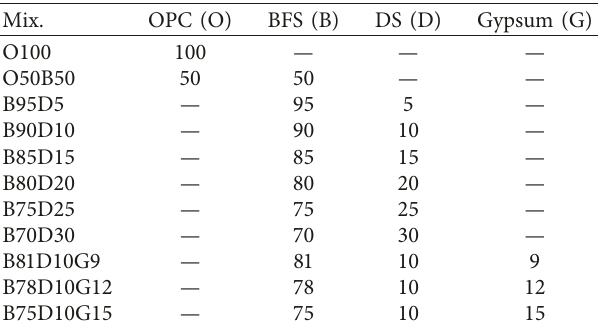
Table 3: Experimental